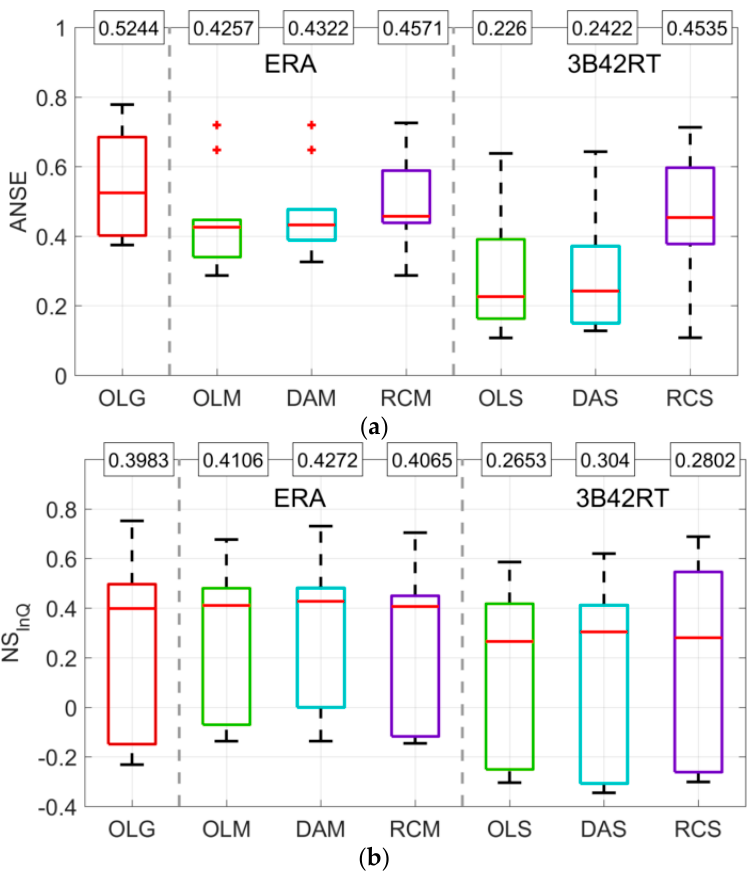
Figure 6. Summary of the results in terms of ANSE (Nash–Sutcliffe efficiency for high-flow conditions) and NS lnQ (NS adapted for low flow conditions) for all the investigated basins during the validation period. Red box plots refer to the results obtained by forcing MISDc with P EOBS datasets; the number in the square boxes represent the median values. Results are shown for the off-line simulations (OLM, OLS), for the SM-corr scheme (DAM, DAS) and for the P-corr scheme (RCM,